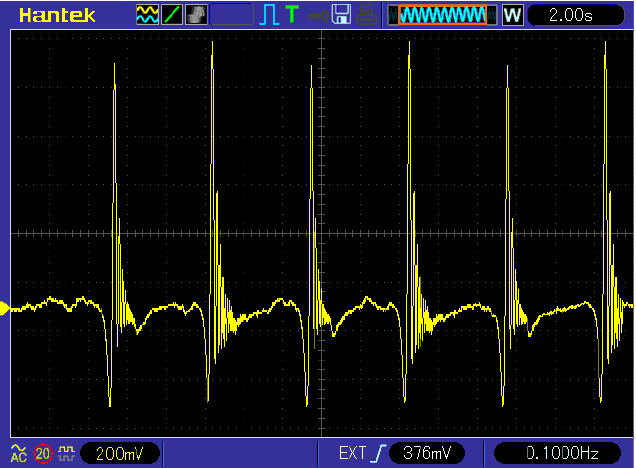
Figure 4. Time dependence of the change in the amplitude of the recorded NMR signal. The modulation frequency of the magnetic field is f m = 0.1 Hz.